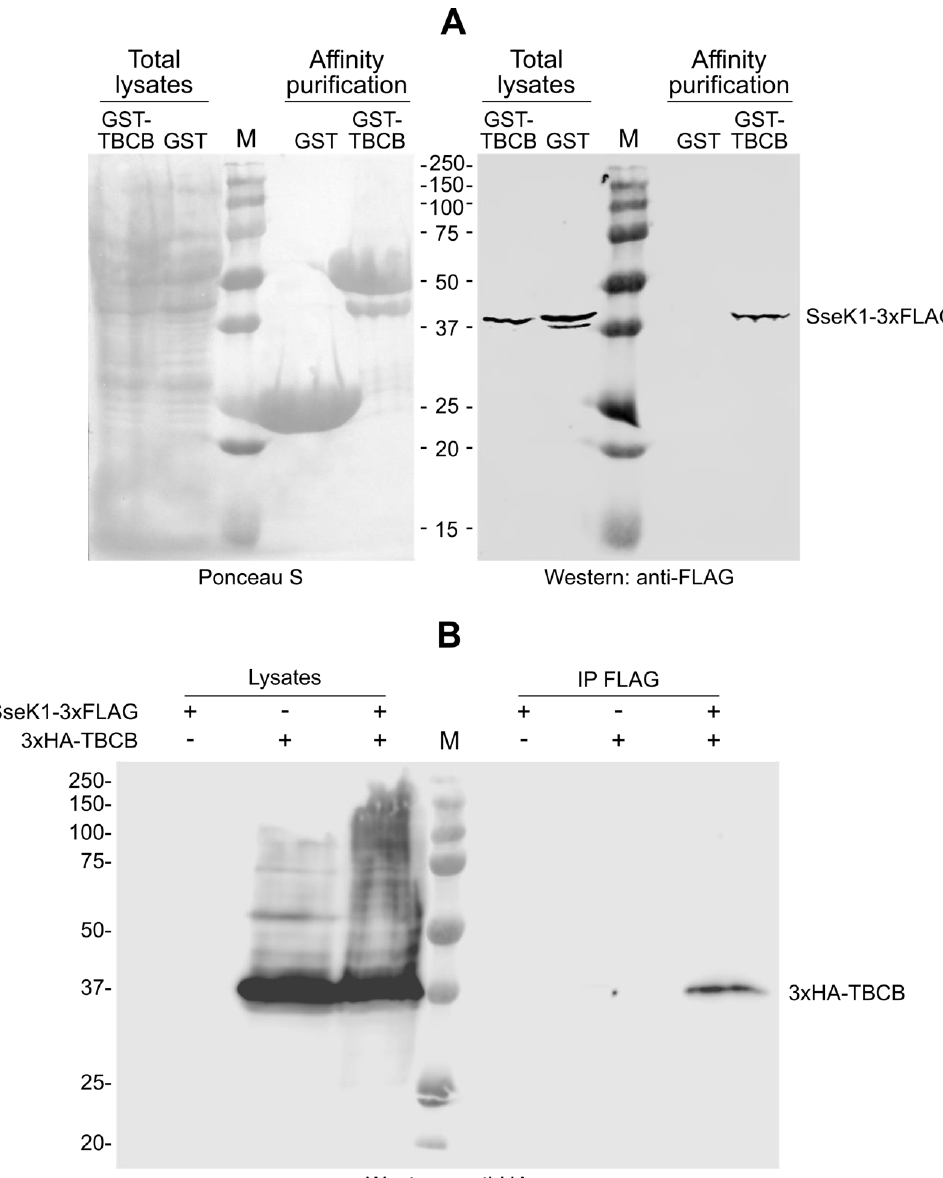
Figure 2. TBCB interacts with SseK1 in bacteria and host cells. ( A ) Bacterial lysates from strain SV7071 (14028 sseK1 ::3xFLAG) expressing glutathione S-transferase (GST) or GST-TBCB were prepared in NP40 buffer. Then, purified GST fusion proteins were blotted on nitrocellulose membranes, stained with Ponceau S red (left panel), and developed with monoclonal anti-FLAG (right panel). Aliquots of the original lysates were also included. The molecular weights of the marker bands (M) are indicated. ( B ) HeLa cells were transiently transfected with a derivative of pBABEpuro expressing SseK1-3xFLAG, a derivative of pCS2 expressing 3xHA-TBCB or cotransfected with the same plasmid and a derivative of pBABEpuro expressing SseK1-3xFLAG. NP40 lysates from 6 × 10 6 transfected cells were subjected to immunoprecipitation (IP) with anti-FLAG monoclonal antibodies and, after washing, resolved by SDS-PAGE, transferred to nitrocellulose membranes, and developed with monoclonal anti-HA. Total lysates from 5 × 10 5 transfected cells are included in the blot. M, molecular weight marker. Molecular weights in kDa are indicated on the left.